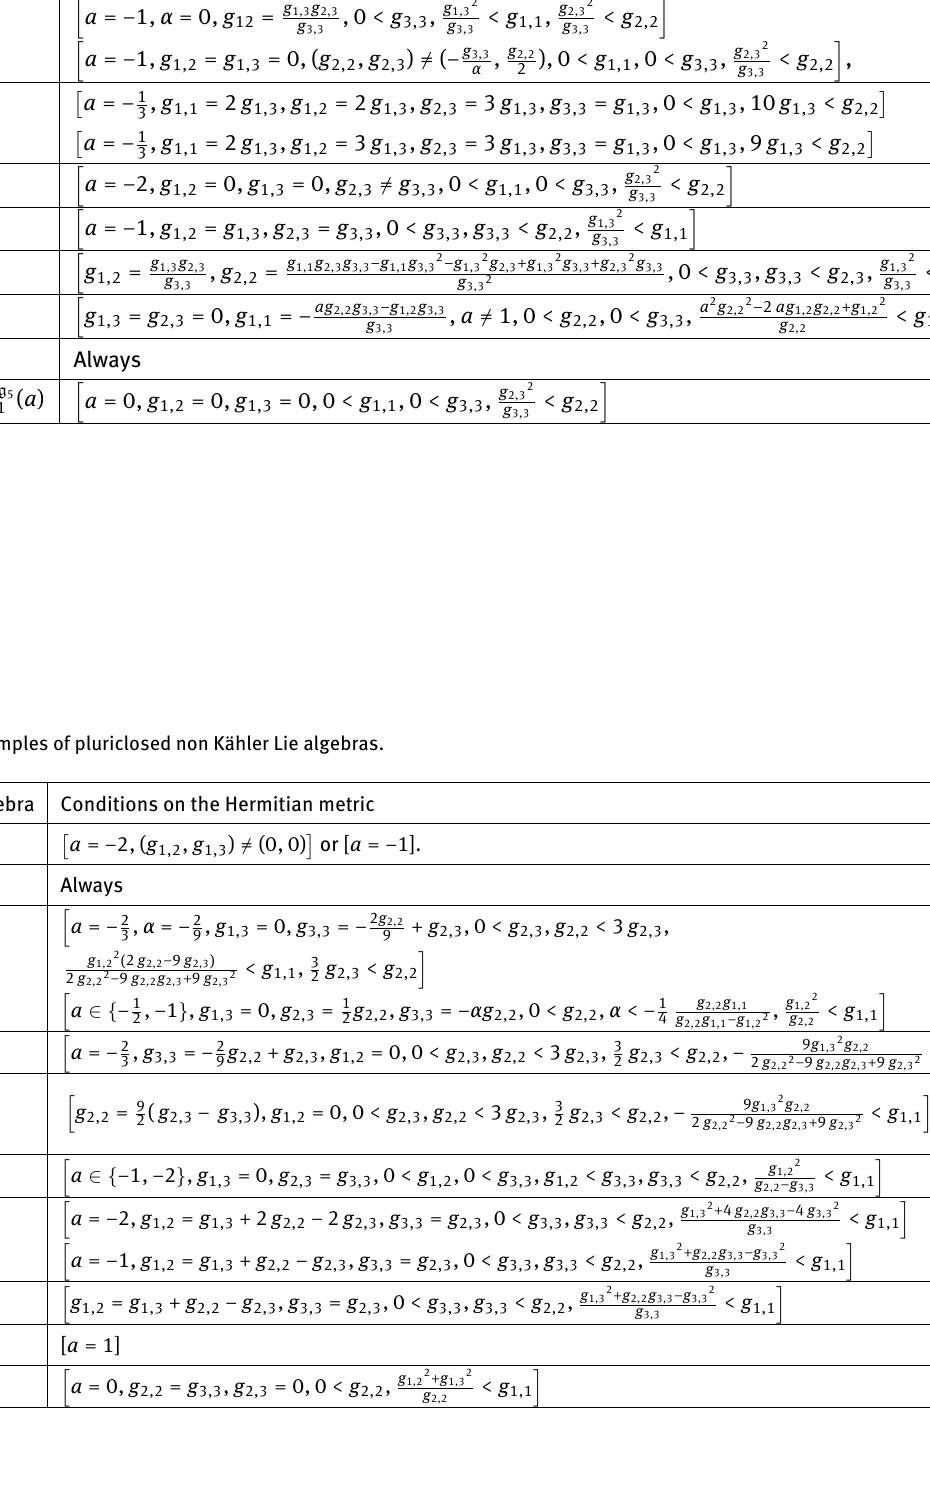
Table 6: Examples of balanced non Kähler Lie algebras. The Lie algebra